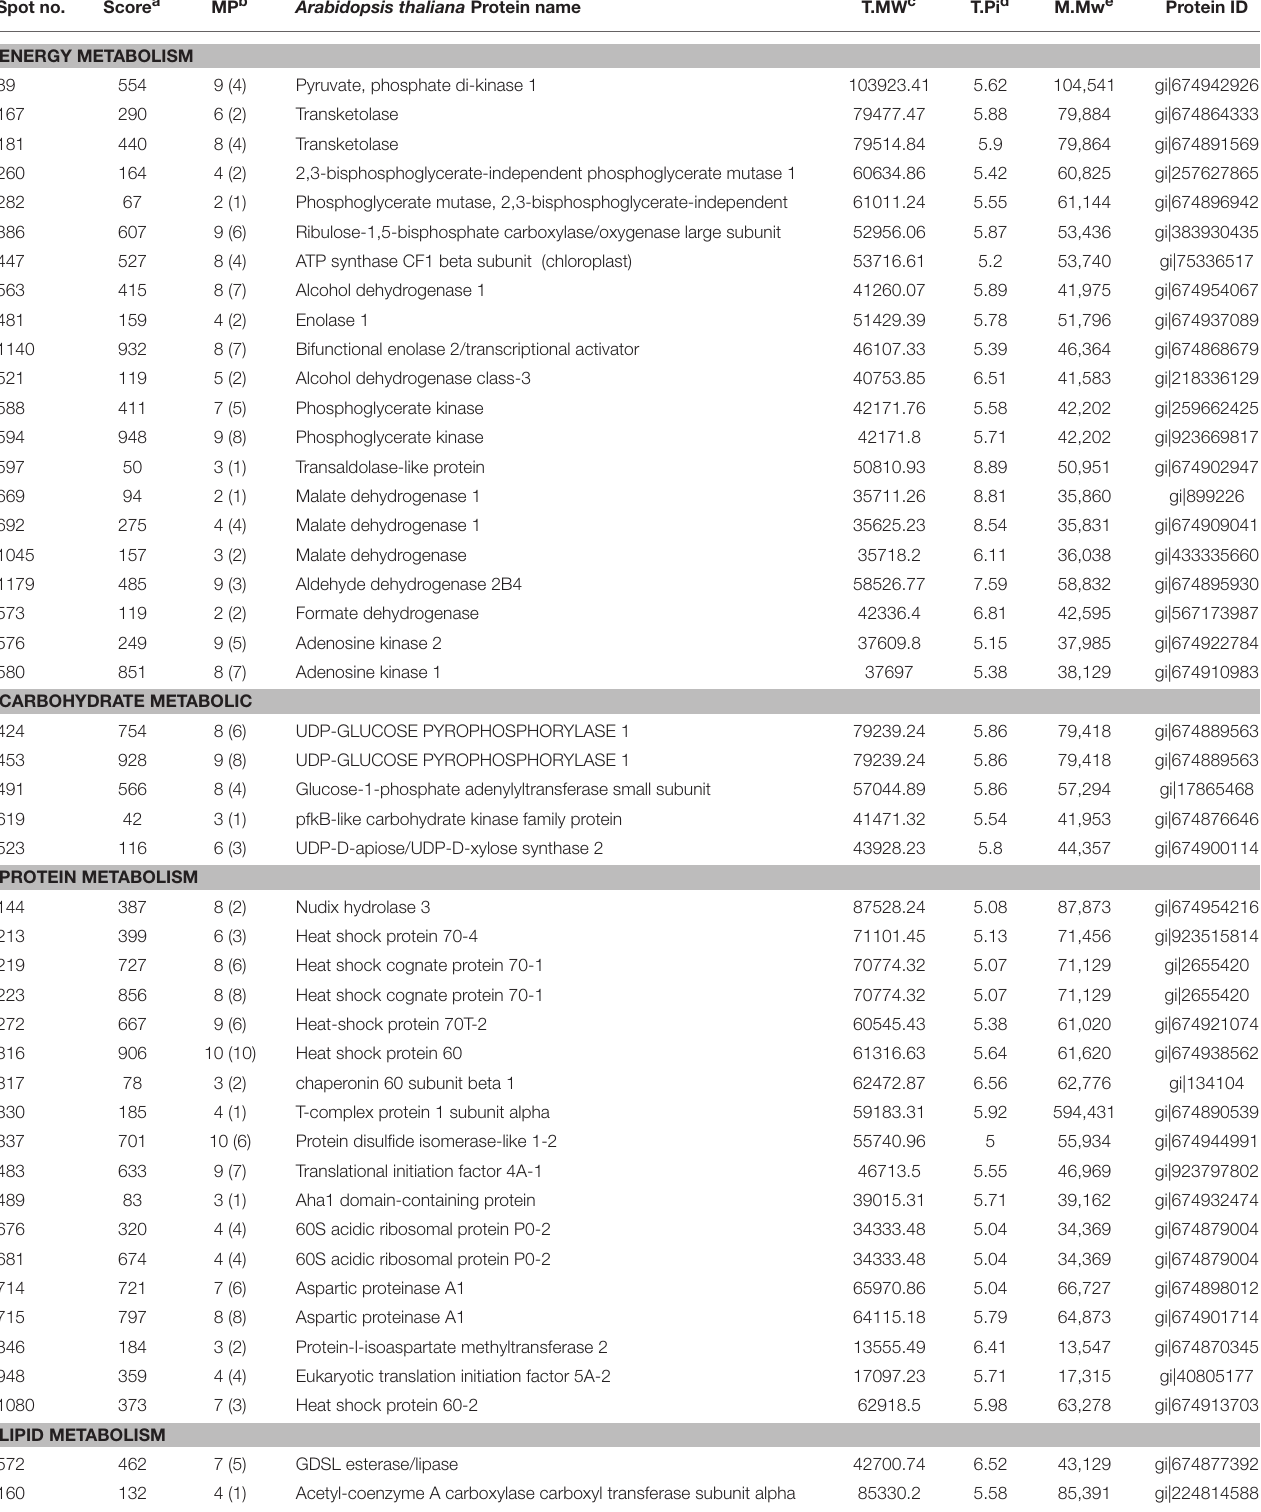
TABLE 2 | Identification of DEPs from seeds during germination and seedling establishment. Spot